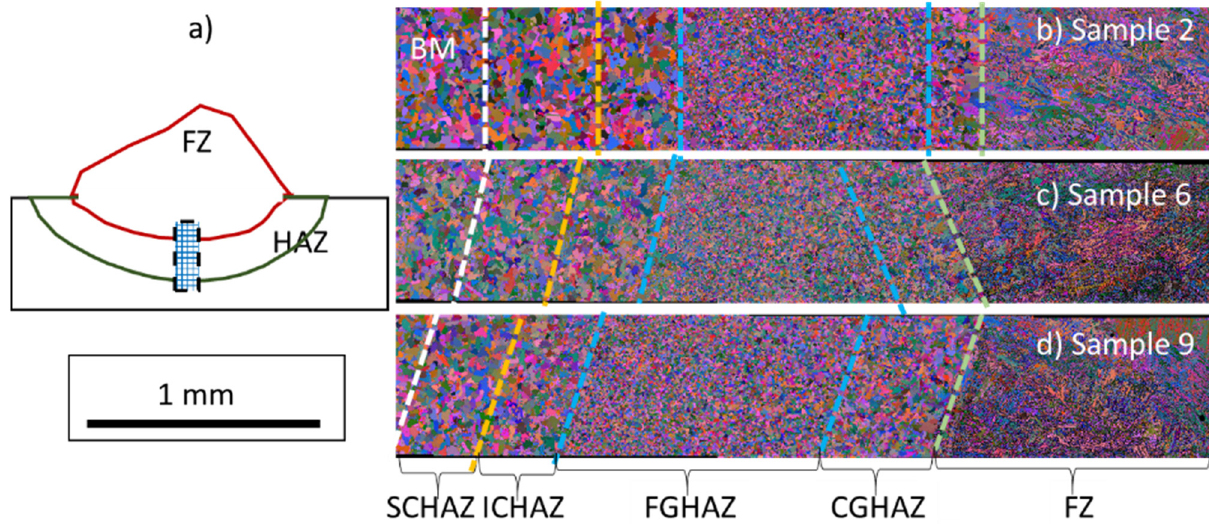
Figure 13. IPF maps showing all regions (from right to left): FZ, CGHAZ, FGHAZ, ICHAZ, SCHAZ, BM. In ( a ), schematic macro view of the IPF maps; in ( b ) sample 2, ( c ) sample 6, and ( d ) sample 9.